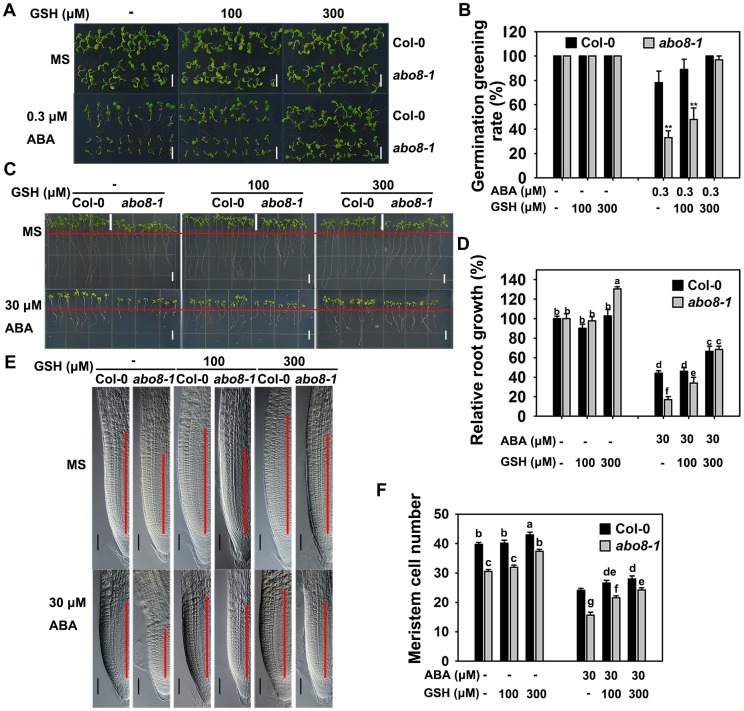
Addition of GSH partially recovers the ABA-hypersensitive phenotypes of abo8-1 mutants.A. Germination greening of wild-type and abo8-1 seeds on MS medium or MS medium containing 0.3 µM ABA, 0.3 µM ABA plus 100 µM GSH, or 0.3 µM ABA plus 300 µM GSH. Bars = 5 mm. B. Statistical analysis of the seed germination greening rate in (A). Three independent experiments were done with similar results, each with three replicates. About 20 seeds were counted from one plate as one replicate. Values are means ±SE from one experiment. **: P<0.01. C. Roots of wild-type and abo8-1 seedlings grown on MS medium or MS medium containing 30 µM ABA, 30 µM ABA plus 100 µM GSH, or 30 µM ABA plus 300 µM GSH. The red line indicates the starting point of root growth after transfer. Bars = 5 mm. D. Statistical analysis of root growth in (C). Root growth is expressed relative to that of the wild type or abo8-1 in MS medium without supplement. Three independent experiments were done with similar results, each with three replicates. Eight roots were measured from one plate as one replicate. Values are means ±SE from one experiment. Means with different letters are significantly different at P<0.01. E. Root meristem zones of seedlings grown on MS medium or MS medium containing 30 µM ABA, 30 µM ABA plus 100 µM GSH, or 30 µM ABA plus 300 µM GSH. Bars = 50 µm. F. Statistical analysis of the MZ cell number in (E). Three independent experiments were done with similar results, each with three repeats, and each repeat with 15–20 roots. Values are means ±SE from one experiment. Means with different letters are significantly different at P<0.01.